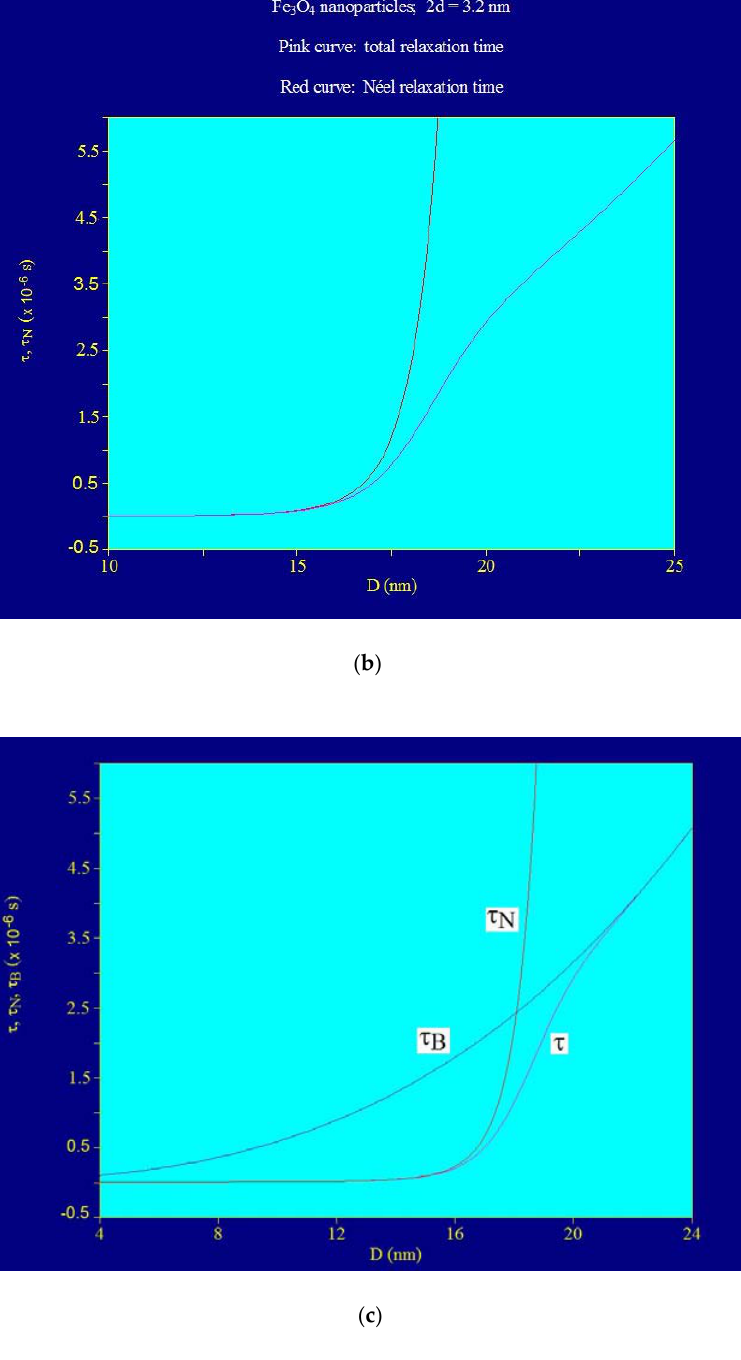
Figure 4. Relaxation times as a function of diameter of Fe 3 O 4 nanoparticles covered with γ -cyclodextrins: ( a ) Néel and Brown relaxation times, ( b ) Néel and total relaxation times, ( c ) Néel relaxation time, Brown relaxation time, and total relaxation time.